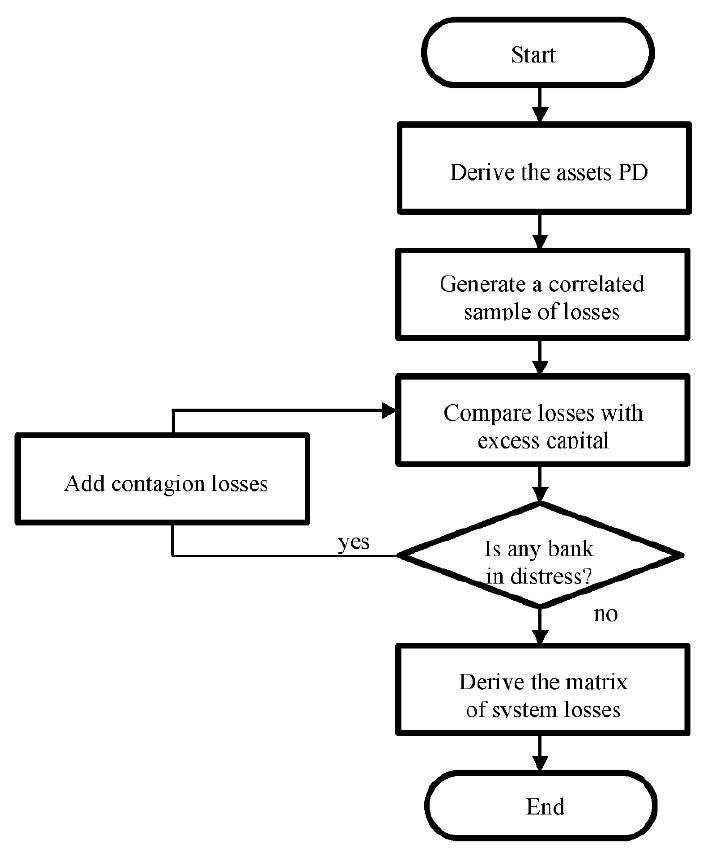
Figure 1. Simulation flowchart .